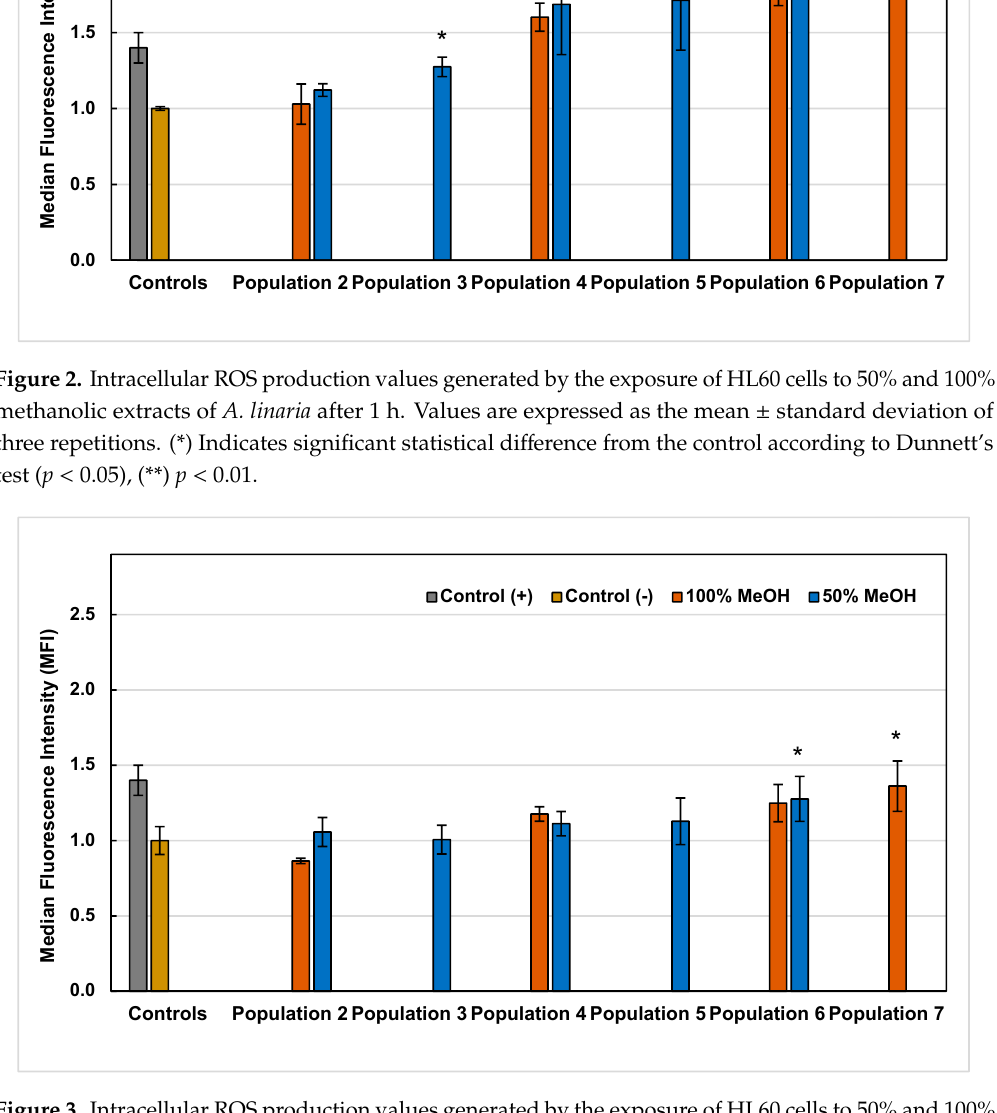
Figure 3. Intracellular ROS production values generated by the exposure of HL60 cells to 50% and 100% methanolic extracts of A. linaria after 3 h. Values are expressed as the mean ± standard deviation of three repetitions. (*) Indicates significant statistical difference from the control according to Dunnett’s test ( p < 0.05).